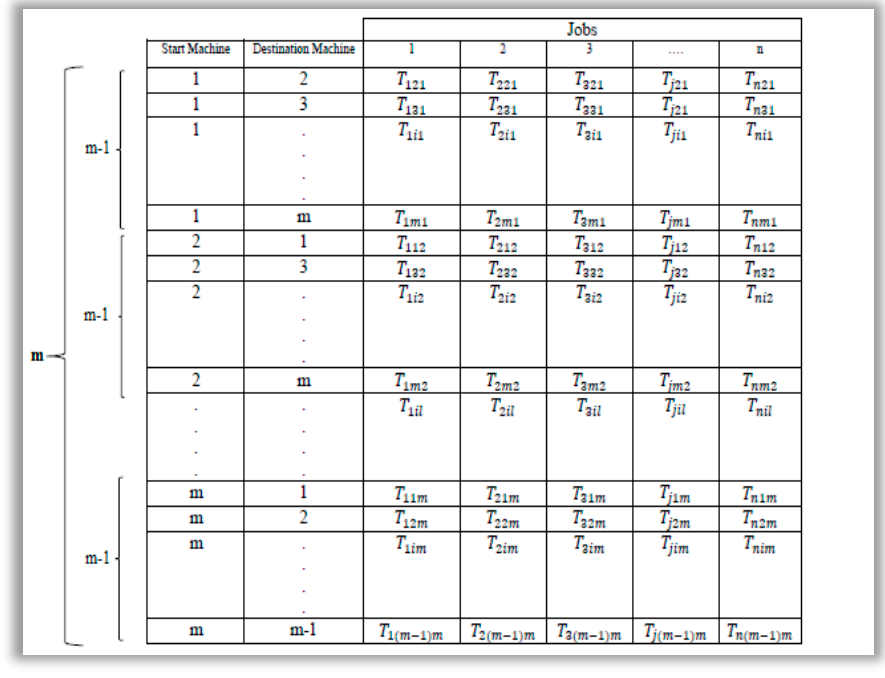
Figure 1. Parameter 𝑇 (cid:3037)(cid:3036)(cid:3039)